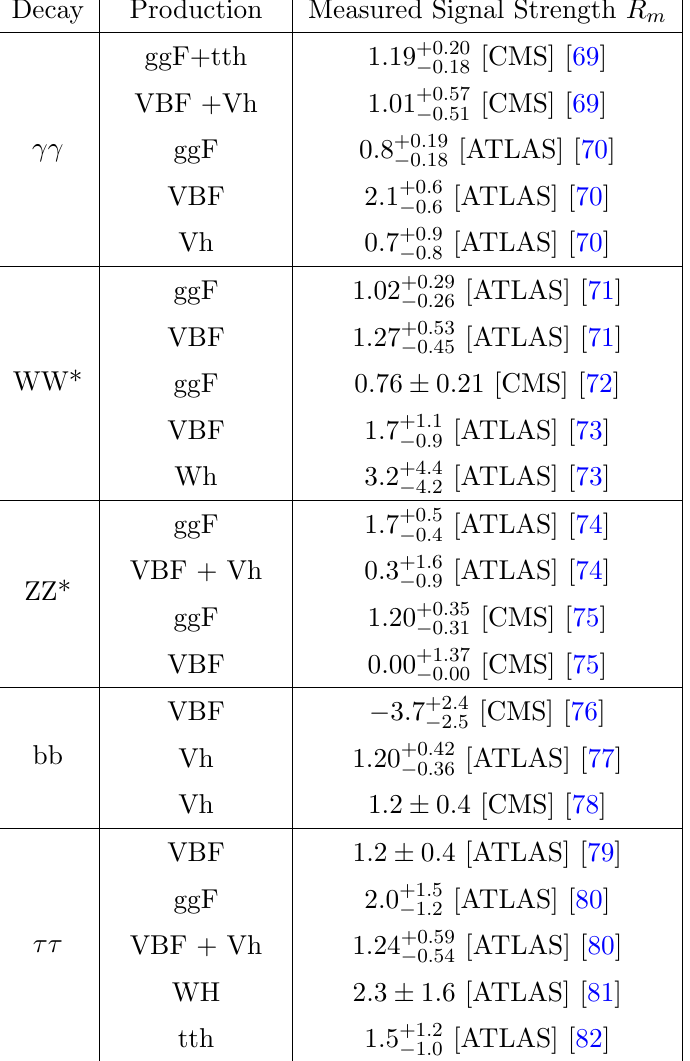
Table 2 . Measured Higgs Signal